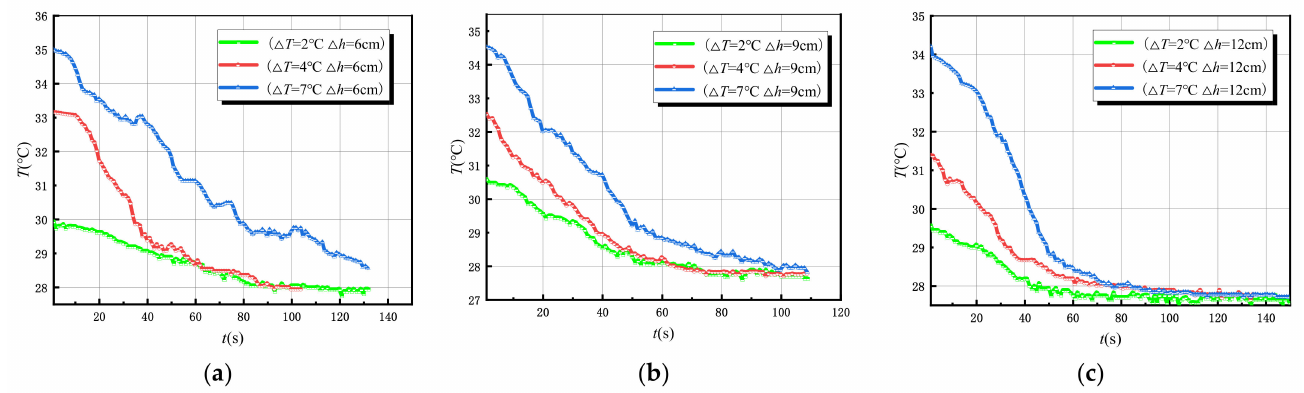
Figure 8. Temperature variation curve of the test well with different excitation strengths during slug heat tests in the case of u (cid:54) = 0. ( a ) ∆ h = 6 cm; ( b ) ∆ h = 9 cm; ( c ) ∆ h = 12